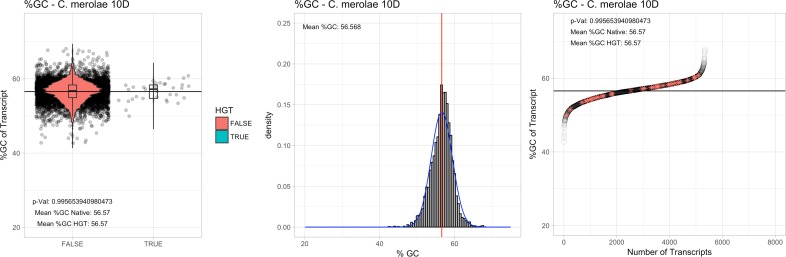
%GC – Cyanidioschyzon merolae Soos: (Left) Violin plot showing the %GC distribution across native transcripts and HGT candidates.(Mid) Cumulative %GC distribution of transcripts. Red line shows the average, blue line a normal distribution based on the average value. (Right) Ranking all transcripts based upon their %GC content. Red ‘*' demarks HGT candidates. As the %GC content was normally distributed, students test was applied for the determination of significant differences between the native gene and the HGT candidate subset.